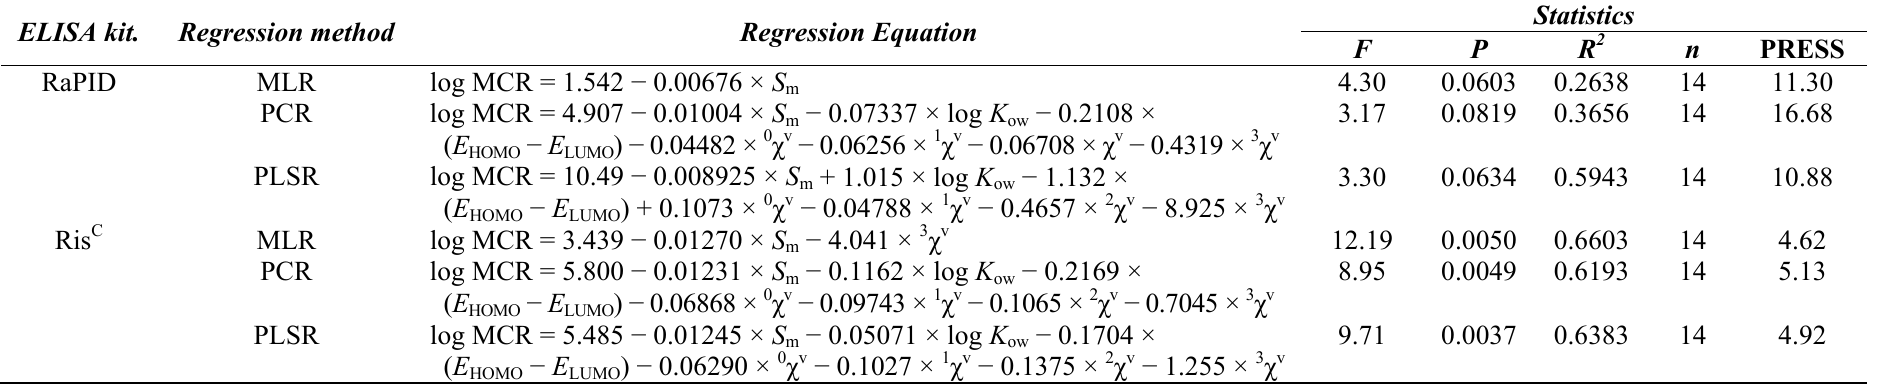
Table 1. Regression models for quantitative structure and molar cross-reactivity (MCR) relationships for the PAHs ELISAs. ELISA kit.